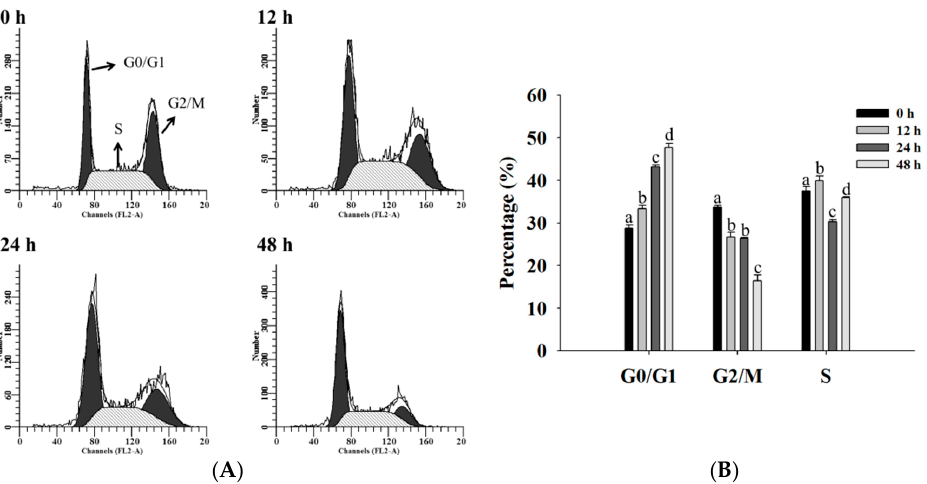
Figure 2. Bufalin induced cell cycle arrest in U-2 OS cells. Cells were treated with 200 nM of bufalin for 0, 12, 24, and 48 h and then were stained with PI (Propidium iodide) for cycle distribution by